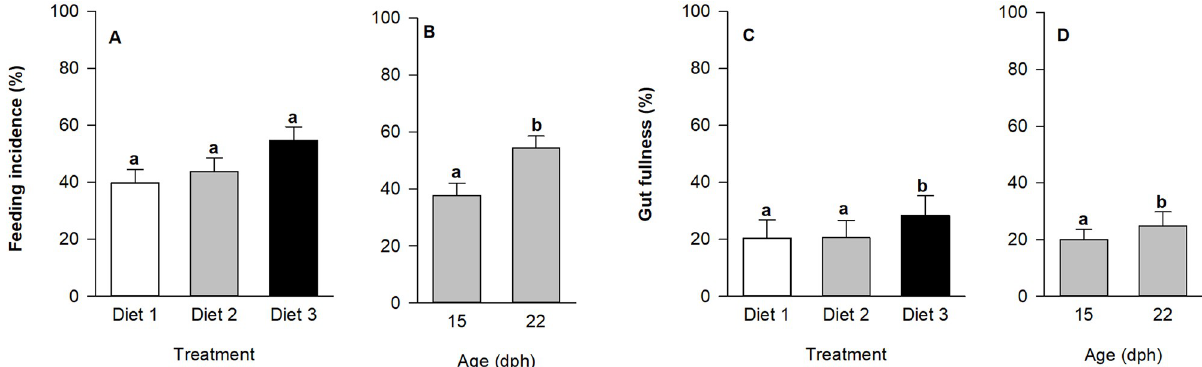
Fig 3. Effect of age and treatment (diet) on larval European eel, Anguilla anguilla , feeding incidence (%) and gut fullness (%). Values represent means ( ± SEM), while different lower-case letters represent significant differences (p < 0.05).